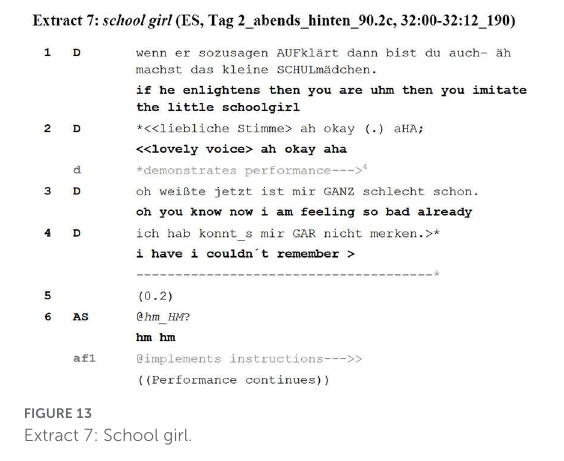
FIGURE13 Extract 7: School